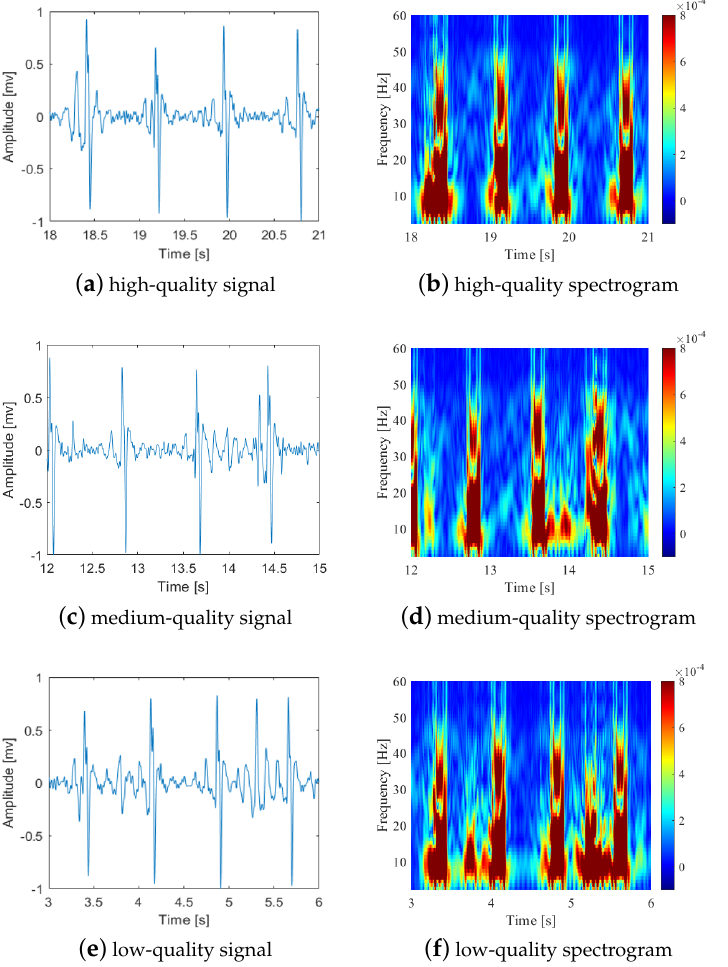
Figure 3. Examples of high, medium, and low-quality FECG signal segments and their corresponding spectrograms. Compared with the high-quality signal segment and spectrogram, the medium- quality one contains some tiny noise, and the low-quality one contains much more noise interference. ( a , b ) high-quality FECG signal segments and corresponding spectrogram; ( c , d ) medium-quality FECG signal segments and corresponding spectrogram; ( e , f ) low-quality FECG signal segments and corresponding